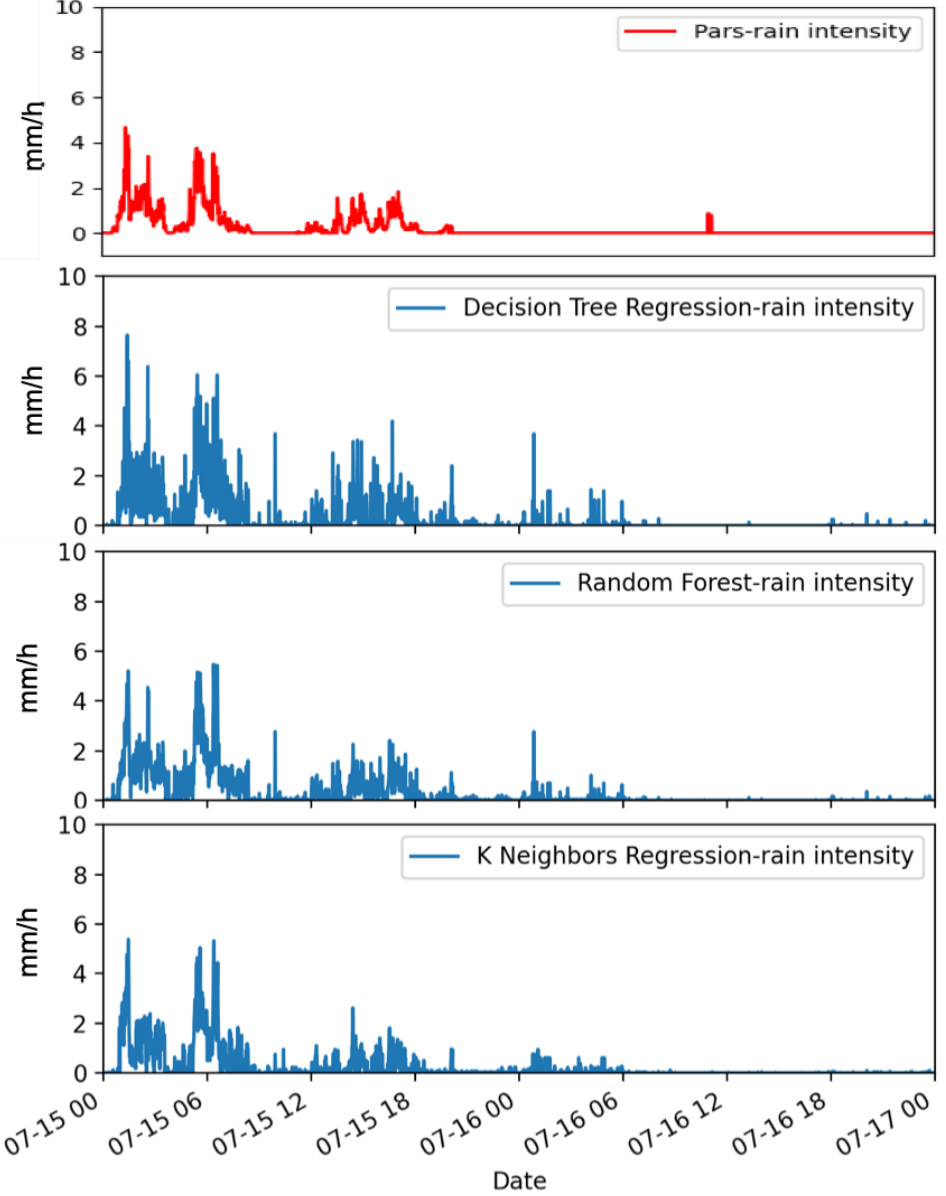
Figure 8. Instantaneous rainfall rate as measured by a co-located reference laser disdrometer (on top) and as estimated by the ML (DTR, RF, KNNR) approaches (from top to bottom, respectively). Data are relative to 15 and 16 July